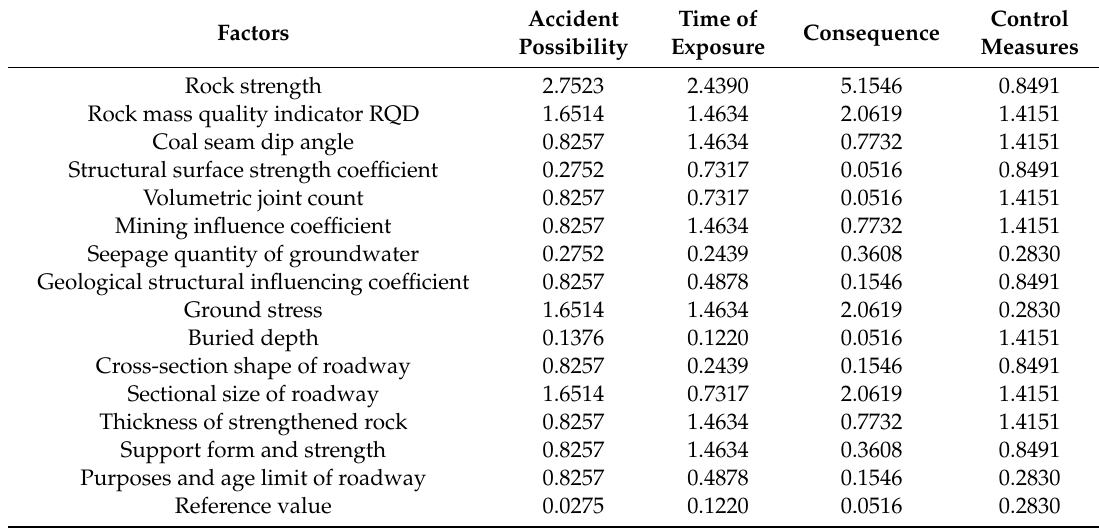
Table 5. Parameter sequence and reference sequence after